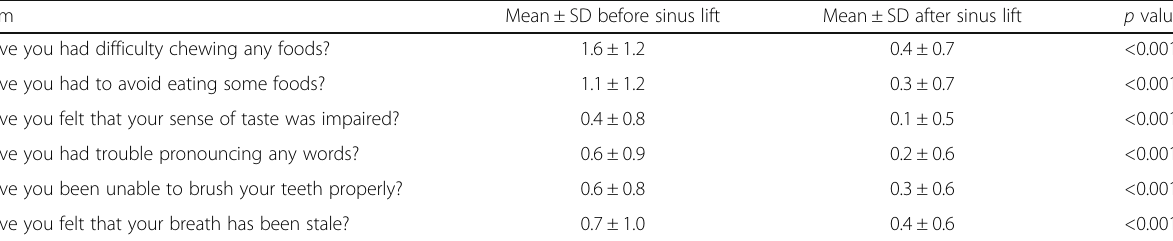
Table 1 Mean value and standard deviation for the subcategory functional limitations Item Mean ± SD before sinus lift